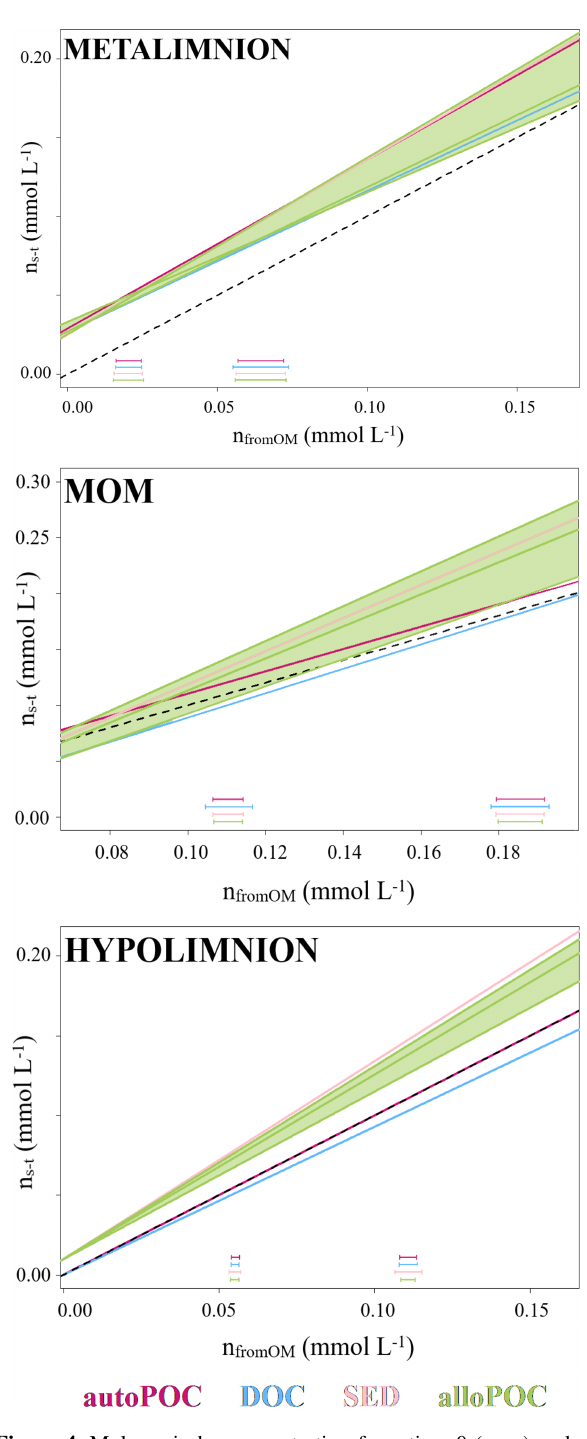
Figure 4. Molar gain by concentration from time 0 ( n s − t ) and as calculated by mass balance with carbon stable isotopes ( n fromOM ) in the metalimnion, MOM, and hypolimnion of the Rappbode Reservoir. Datasets are reported in different colors according to the considered OM. Green fields represent the variation of allo-POC. Standard variations for each OM are reported at the bottom of the